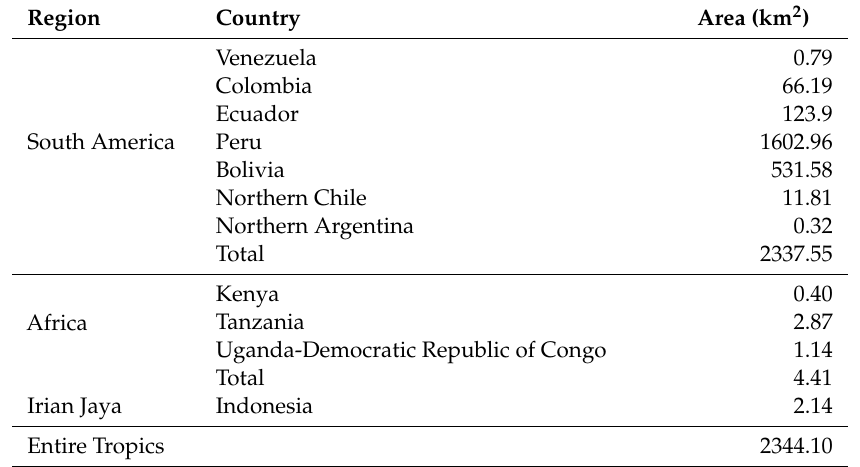
Figure 1. Distribution of tropical glaciers globally. Table 1. Tropical glacier areas by region and country using data from the Randolph Glacier Inventory.